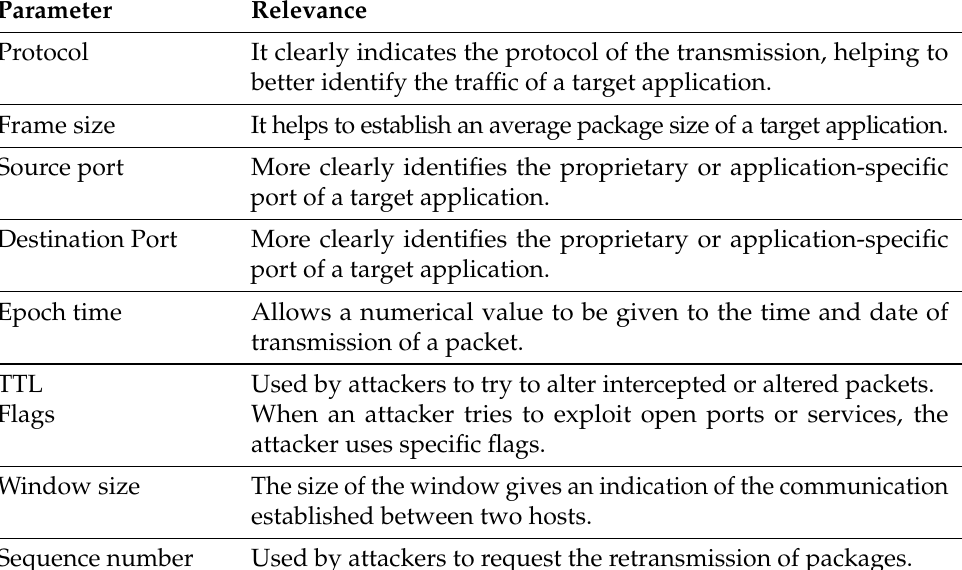
Table 2. Selected TCP/IP